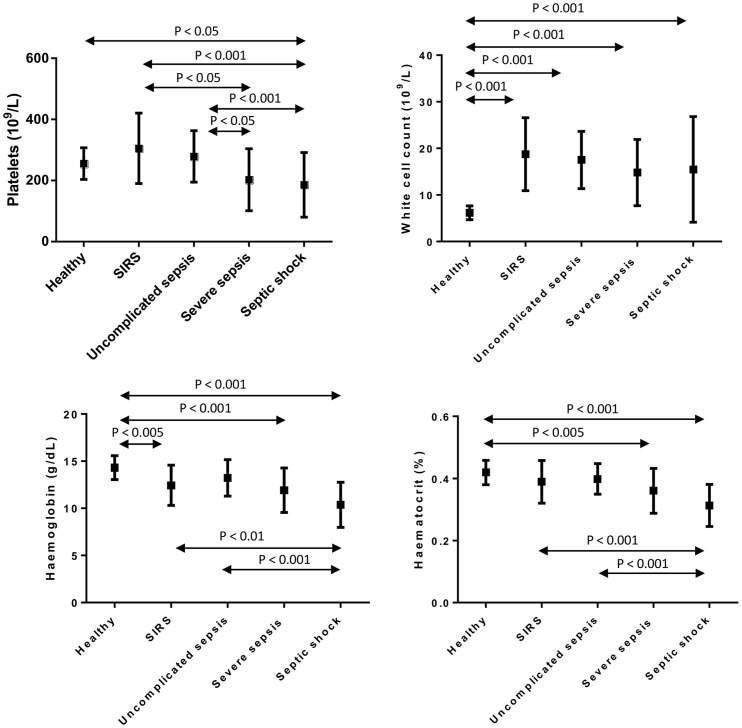
Comparison of whole blood parameters in different pathological groups and healthy control.Platelet count, white cell count, haemoglobin and haematocrit measurements are shown in different pathological groups and healthy control. Significant differences between the groups are indicated by p-values, as assessed by Bonferroni post-hoc analysis.